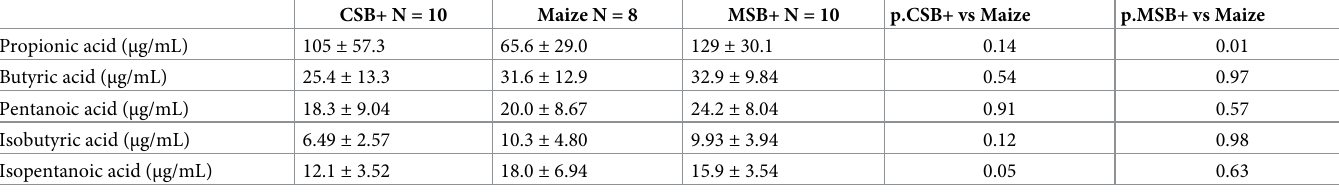
Table 3. SCFA concentrations in the colon